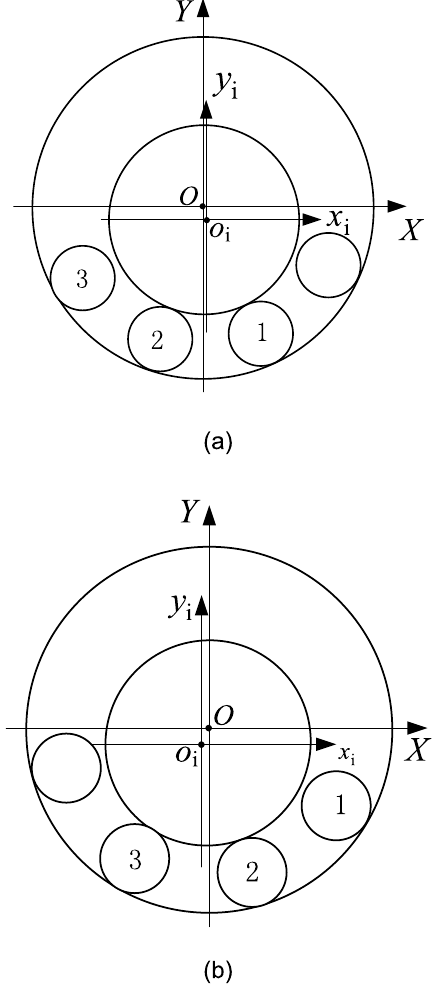
Figure 8. Contact status of inner ring with inner raceway for an ellipse.